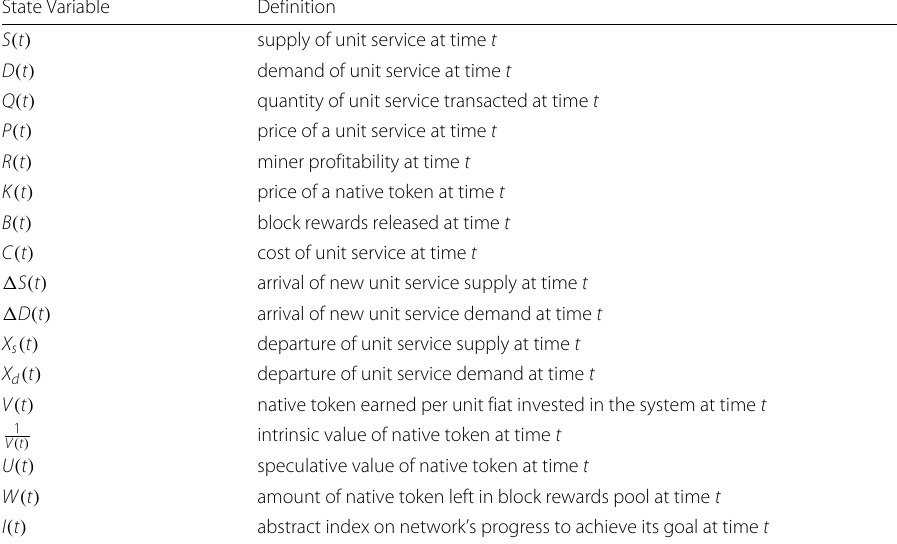
Table 1 Definitions of system state